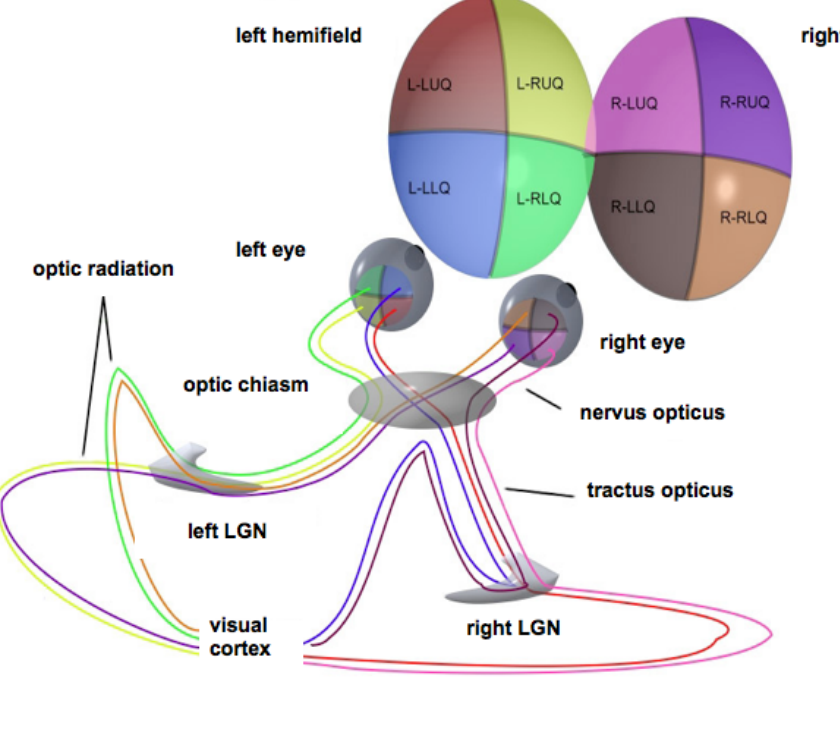
Figure 1. Schematic representation of the optic pathways from each of the four quadrants of view for both eyes. Adapted from Wikimedia Commons, original illustration by Ratznium. LGN, lateral geniculate